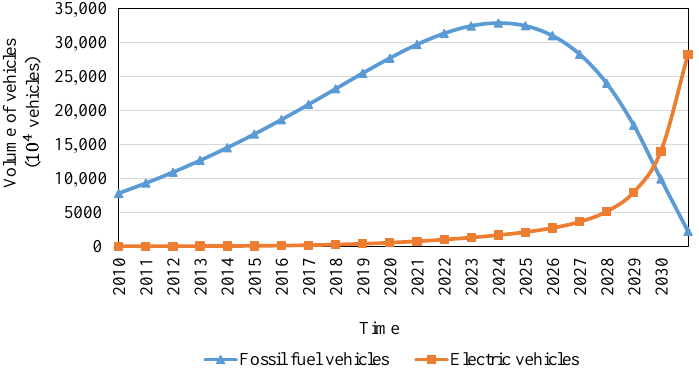
Figure 8. Number of fossil fuel vehicles and electric vehicles under the benchmark scenario.